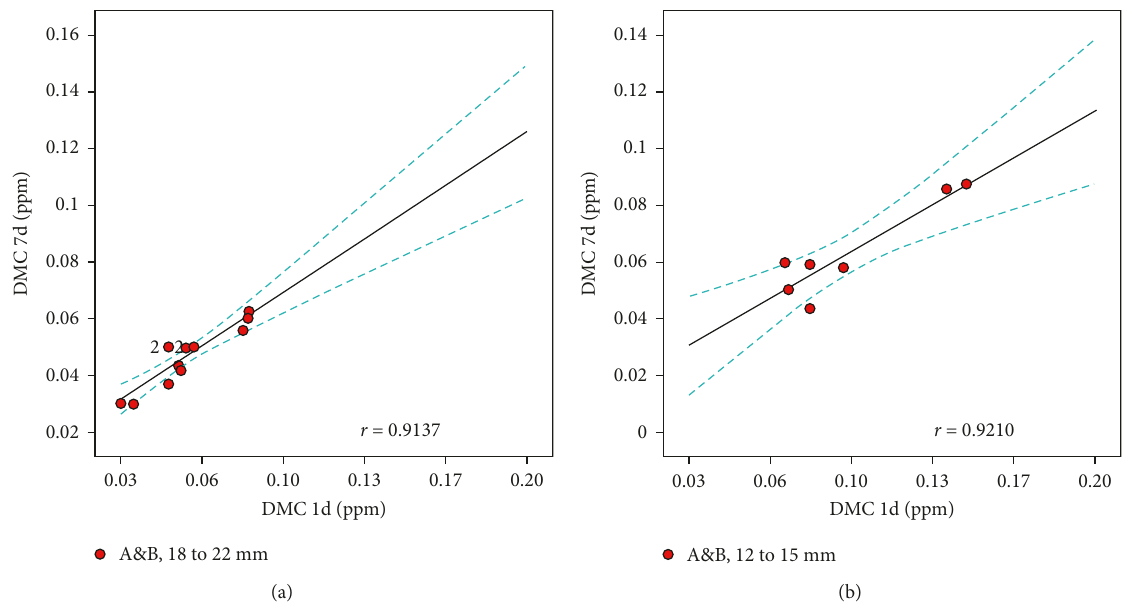
Figure 6: Correlation between the 1-day and 7-day DMC emissions of the particleboard types A and B with thickness of (a) 18 to 22mm and (b) 12 to 15mm. Circles represent values measured from different production batches, dotted lines represent confidence bands, and numbers before circles indicate more than one measurement at the same location. No outliers exist for (a) and (b). Upper and lower fences are 0.064 and 0.030 for (a) and 0.101 and 0.027 for (b).